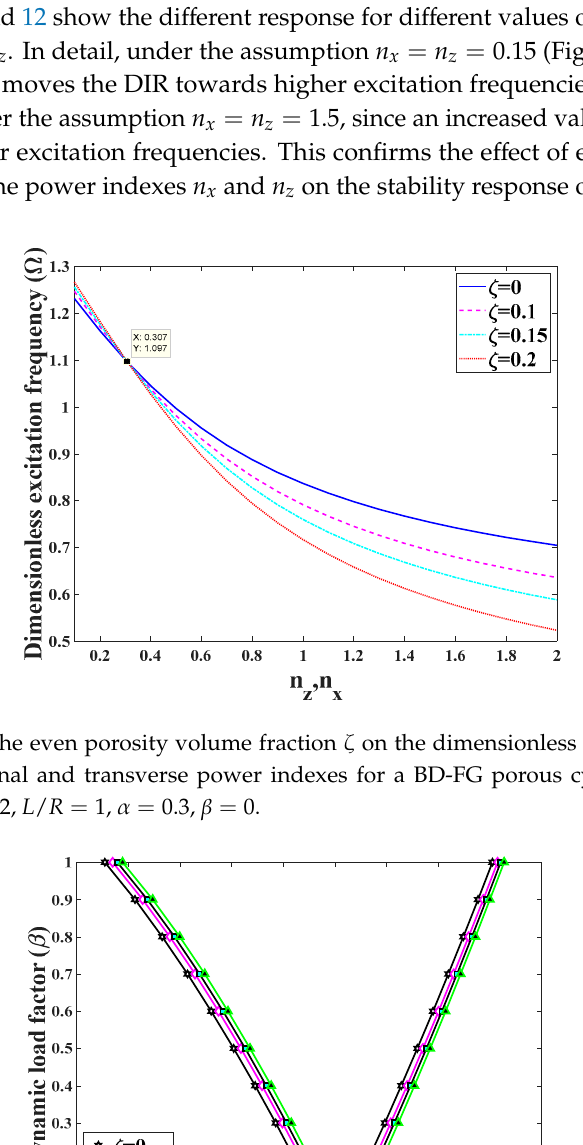
ζ on the DIR for a BD-FG porous cylindrical